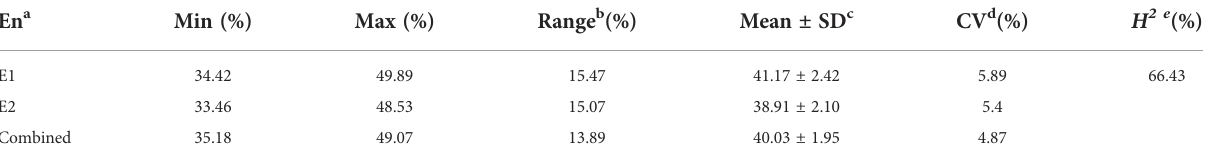
TABLE 1 Descriptive statistics for soybean protein content of the natural population.